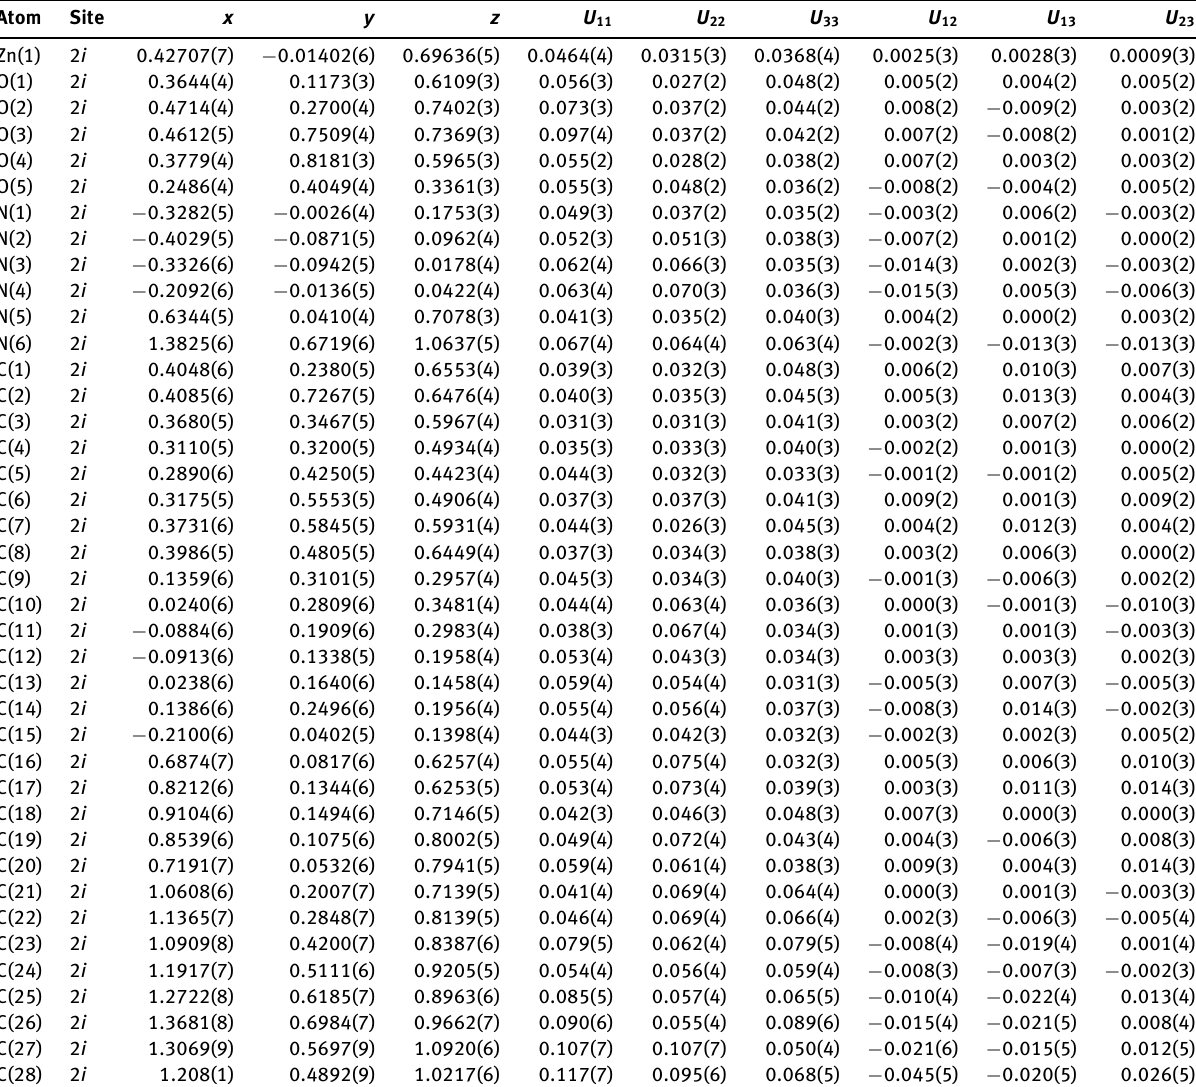
Table 3: Fractional coordinates and atomic displacement parameters (Å 2